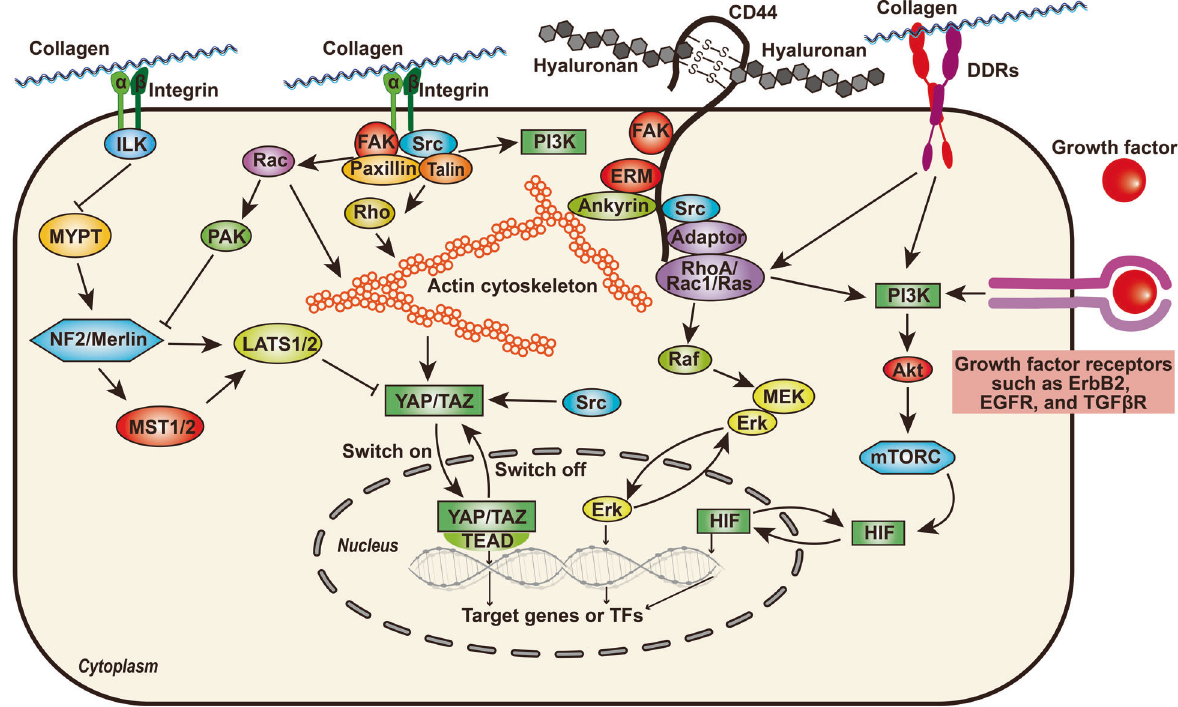
Fig. 5 Schematic summary of key membrane receptors recognizing ECM components and their downstream signaling